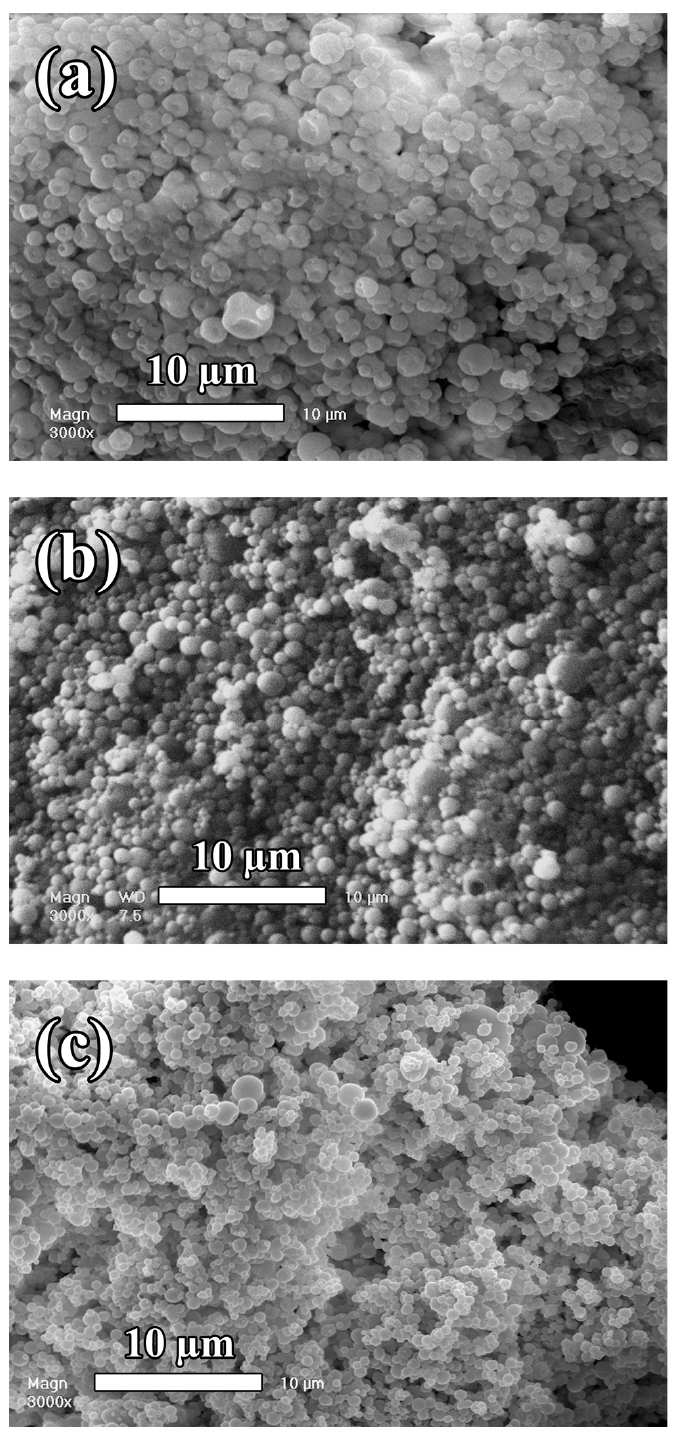
Figure 4. Trojan microparticles encapsulating nano-emulsions. ( a ) Wall materials: gum Arabic, Spray drier: Büchi Mini Spray Drier B-290. ( b ) Wall materials: gum Arabic, Spray drier: Büchi Nano Spray Drier B-90. ( c ) Wall materials: whey protein, Spray drier: Büchi Mini Spray Drier B-290. ((a) and (c) from [26], and (b) Reproduced with permission